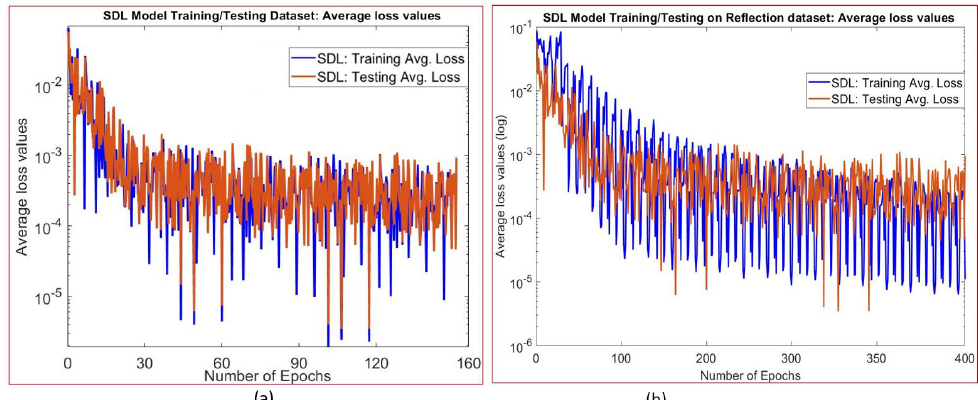
Figure 3. ( a ) Spatio-temporal deep learning (SDL) model, for forward wave propagation: training and testing average loss values over the number of epochs for the type-1 datasets. ( b ) Spatio-temporal deep learning (SDL) model, for reflected wave propagation: training and testing average loss values over the number of epochs for the type-2